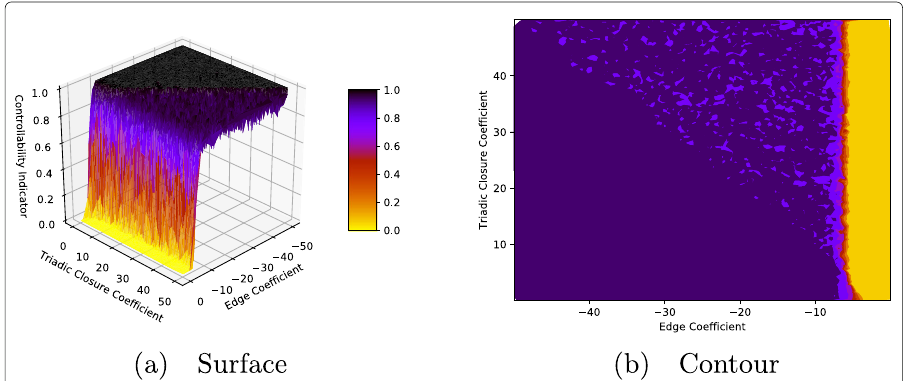
Fig. 3 Simulation Results. In a simple formation model, edge costs are the most important determining factor of network controllability, and triadic closure appears to matter on the margin. This figure highlights the stark impact of θ l on controllability, driven by the phase transition from dense to sparse networks which occurs due to rising edge